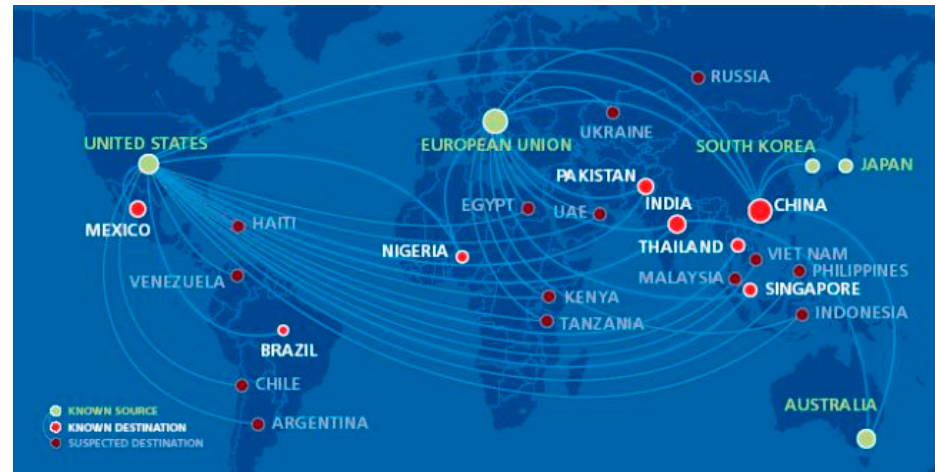
Figure 4. Estimation of the legal and illegal WEEE flow from high-income to low-income countries at global level [94].